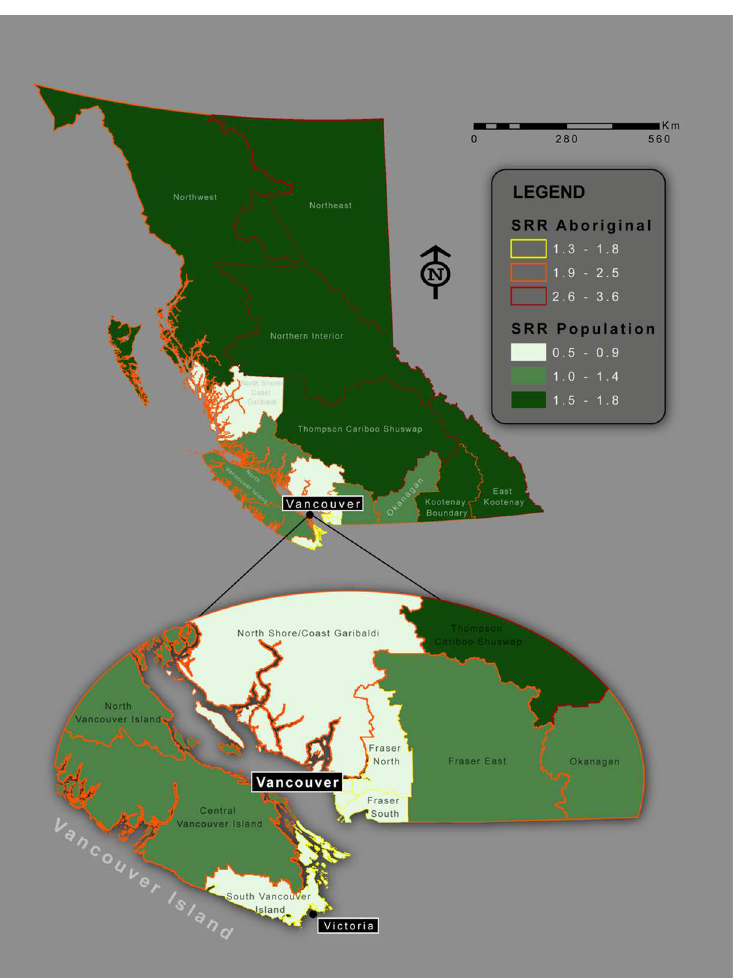
Fig 1. SRR of hospital separations due to unintentional transport injuries by HSDA, British Columbia, 1991– 2010.